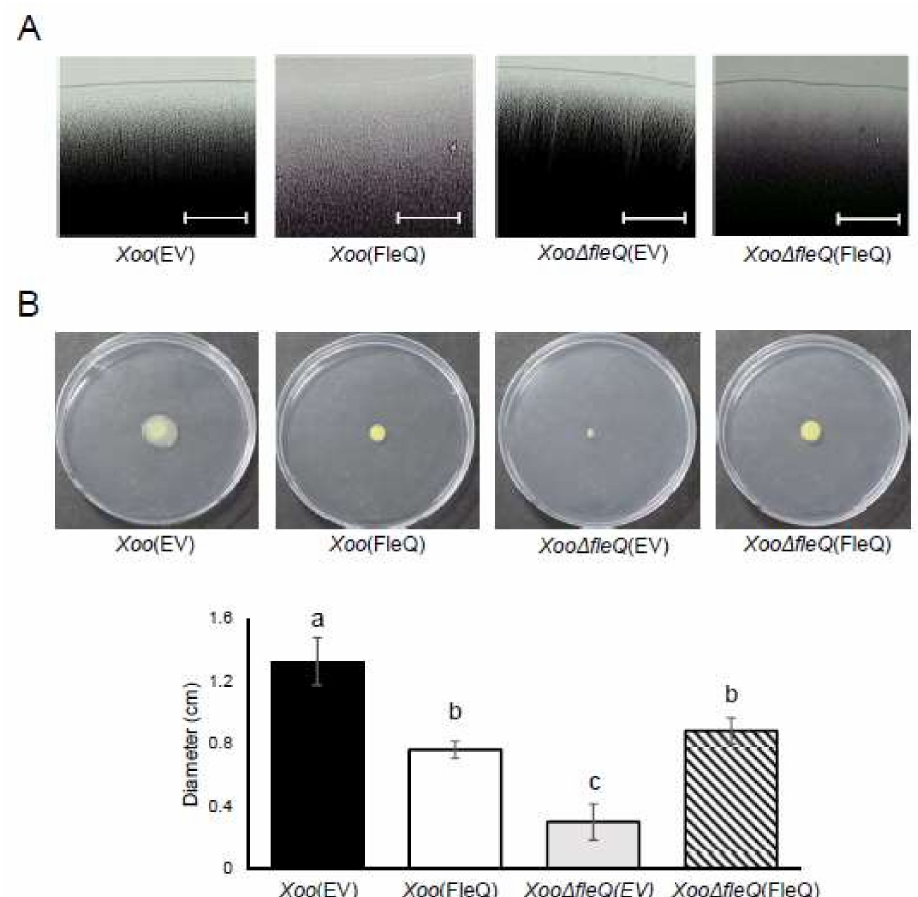
Figure 4. Twitching and swarming motility in Xoo strains. ( A ) After a 3-day incubation on a peptone sucrose agar (PSA) plate, twitching motility from the colonies was oberved by light microscopy. White bars represent 100 µ m. ( B ) Swarming motility was observed by a light microscope and analyzed by measuring the diameter of colonies after 7 days incubation on semi-solid XOM2 media. Different letters on the bars indicate statistically significant differences in average values by one-way ANOVA ( p <